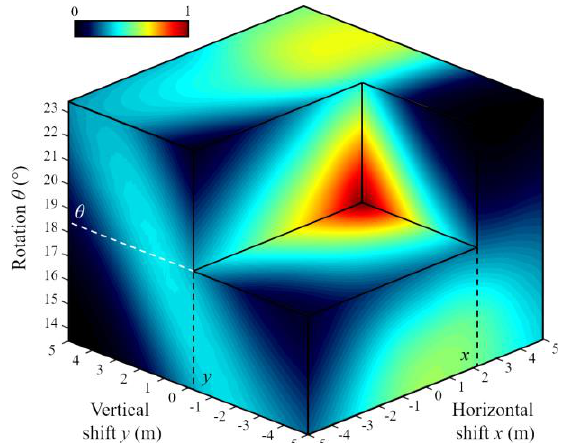
Figure 8. 3D correlation matrix example. The maximum of the matrix is used to determine the shift ( x , y ) and orientation θ of the robot within the map.